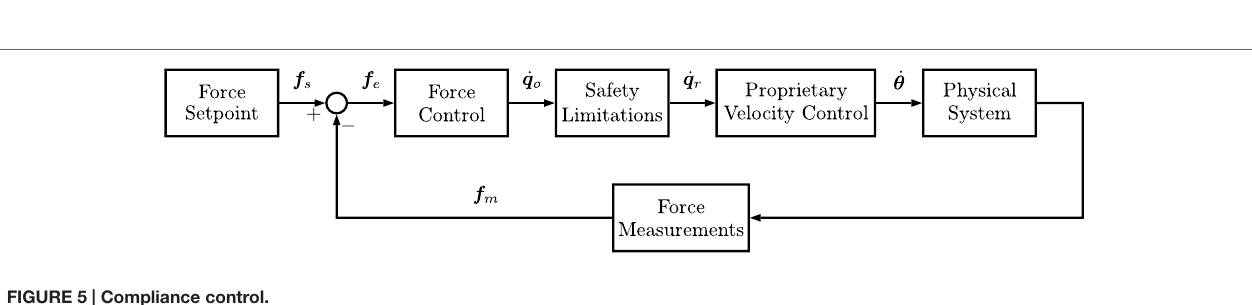
FigUre 5 | compliance